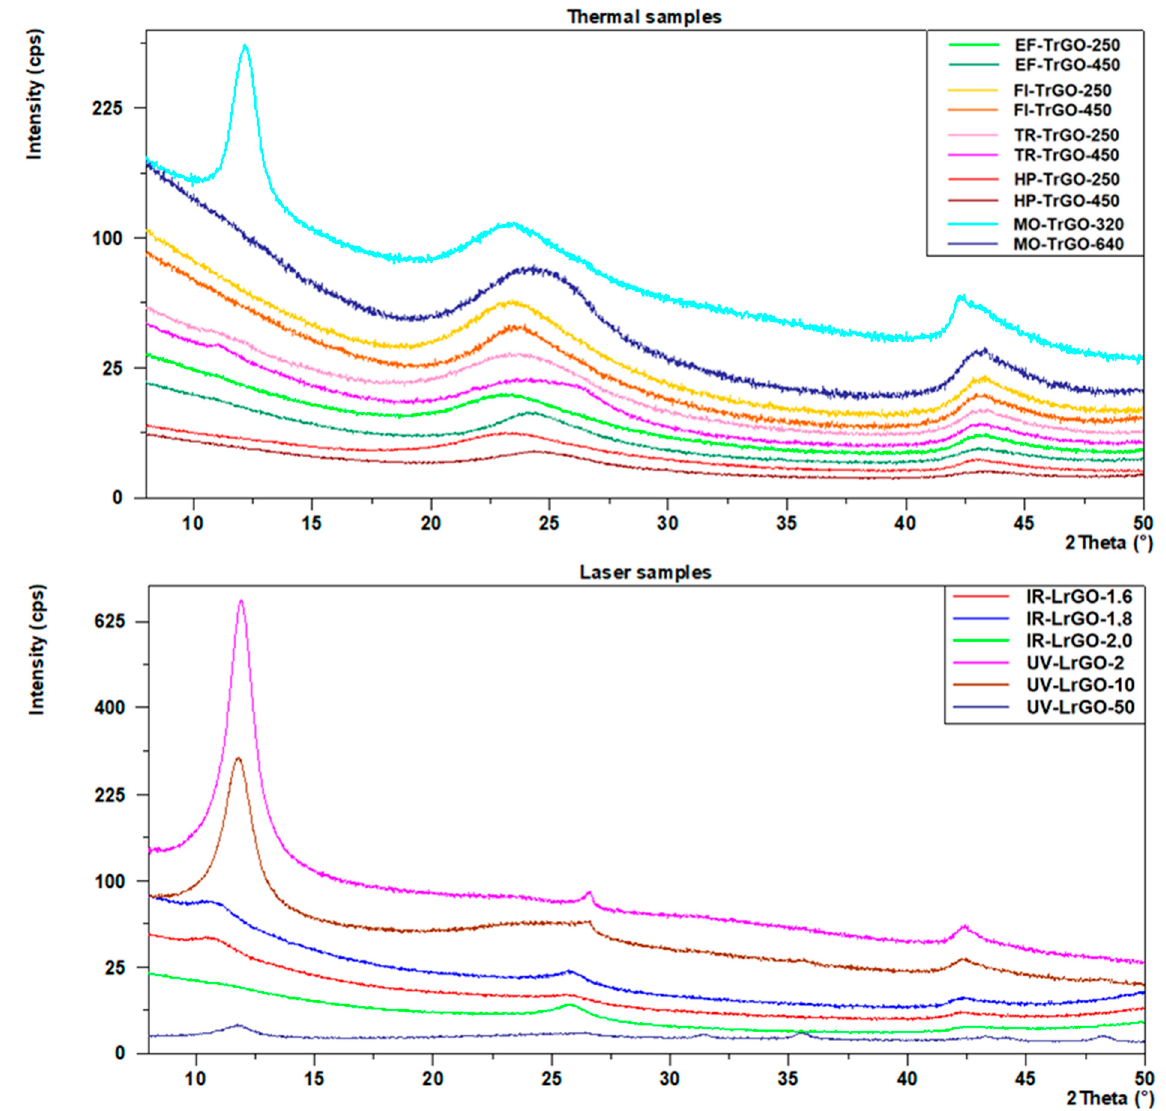
Figure 3. XRD peaks for the samples after the di ff erent thermal reduction treatments ( top ) and the samples after the di ff erent laser reduction treatments ( bo tt om ). Table 2. Comparison of structural parameters resulting from the XRD analysis of the samples.